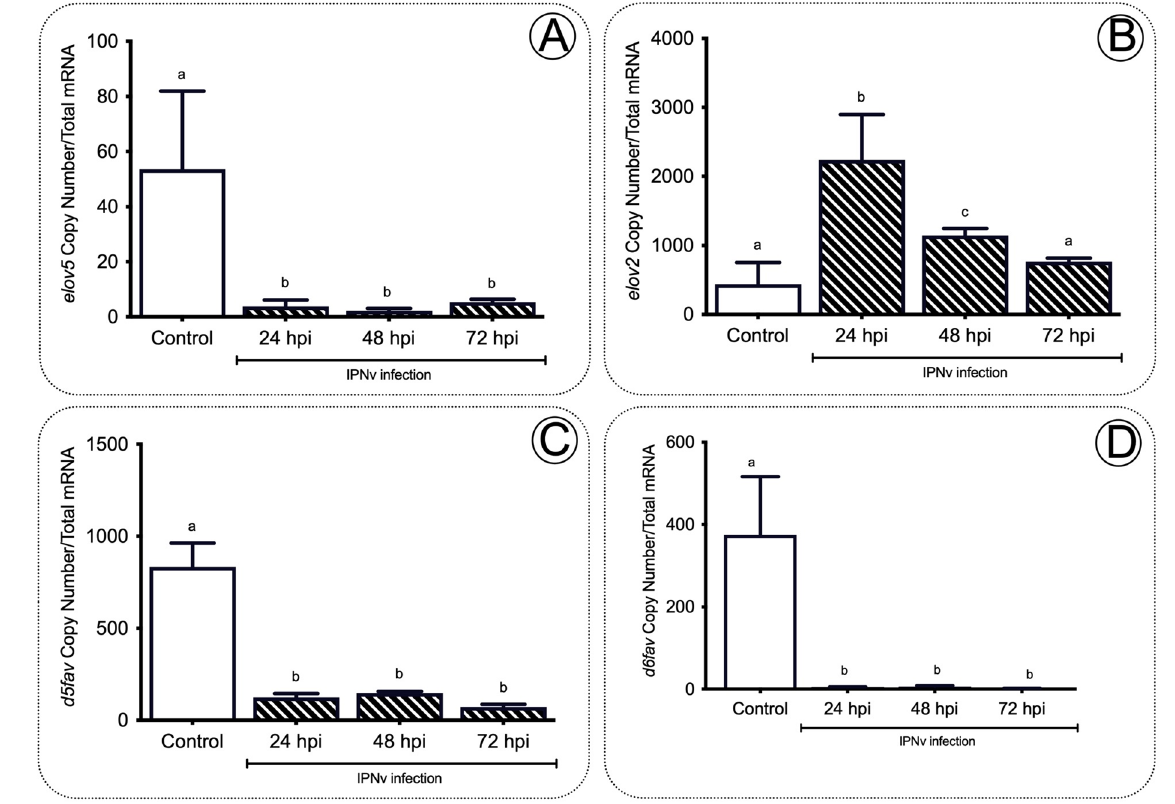
Figure 4. Elongases and desaturases expression profiles in the liver of salmon during infection. The elovl5 ( A ) , elovl2 ( B ), d5fad ( C ), and d6fad ( D ) gene expression profiles after IPNv infection on salmon liver tissue. Control sample corresponds to unchallenged fish. Data represent the mean ± SEM. One-way ANOVA; p < 0.05 was considered statistically significant. Different letters denote significant differences.